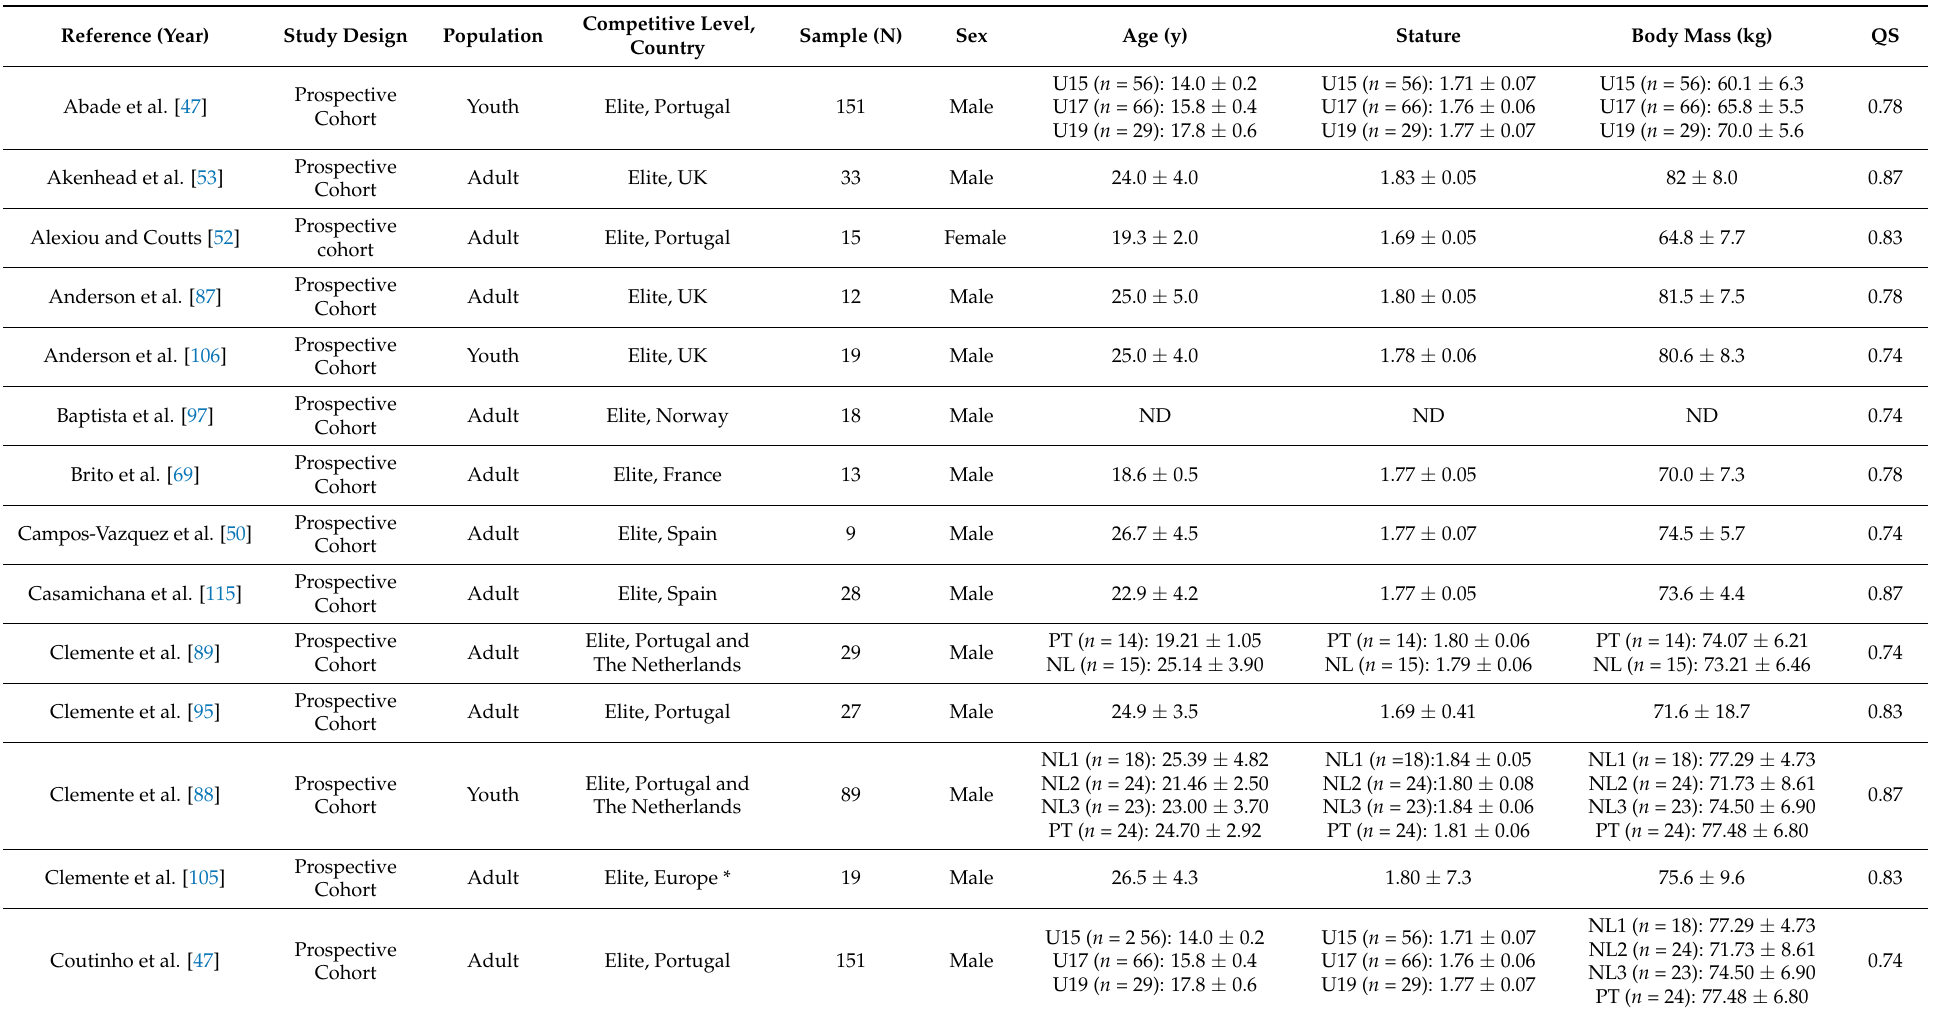
Table 3. Summary characteristics of the participants’ demographics recruited in the studies included in the systematic review and its quality